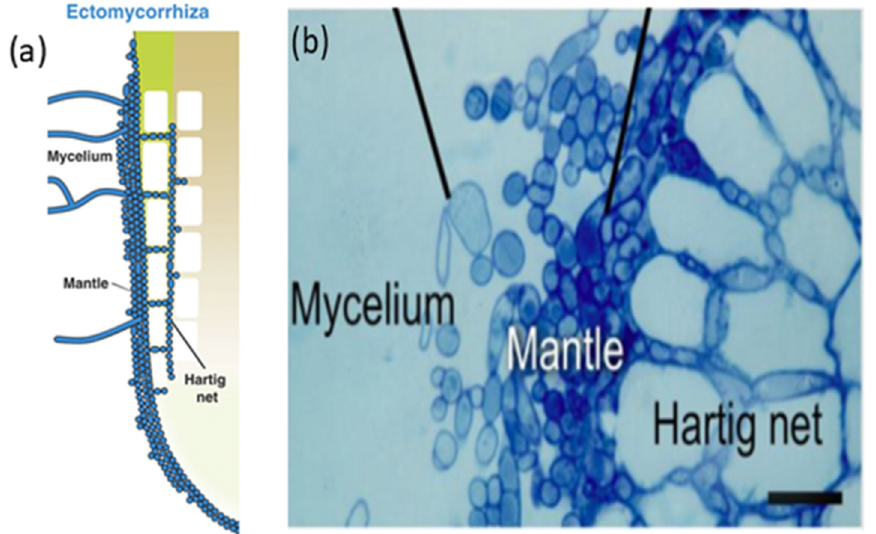
Figure 1. ( a ) Illustration of root colonization structures in ectomycorrhiza ( b ) Hartig net formation of EM fungi. Outbreak of hyphae of mycelium in intracellular space with no penetration in lumen [37] Mechanisms underlying beneficial plant-fungus interactions in mycorrhizal symbiosis.